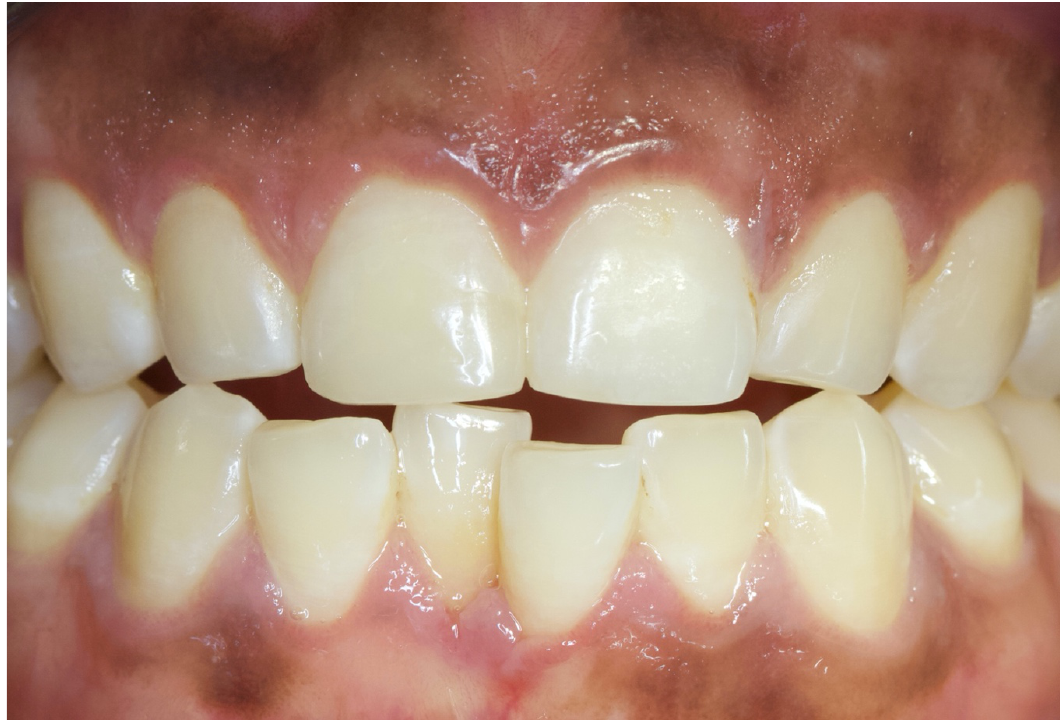
Figure 5. Control of the restoration of tooth 11 in the ASD patient after three months. ( © Dr. Peter Schmidt).